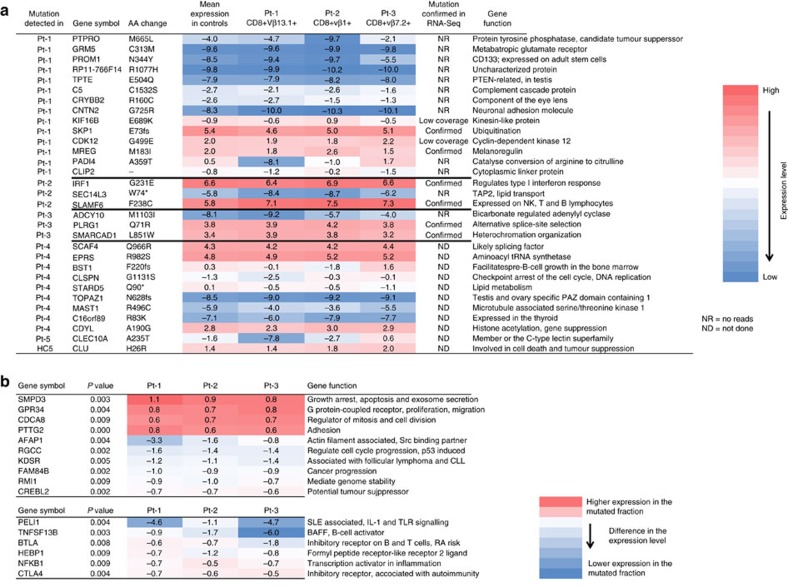
Expression levels of mutated genes and a survival signature in mutation-harbouring cells.CD8+ cells from 3 healthy controls as well as mutation-harbouring CD8+Vβ+ and polyclonal CD8+ T cells from patients 1, 2, and 3 were sorted with flow cytometry. (a) RNA sequencing was performed on the sorted fractions. The normalized mean expression levels calculated from the healthy CD8+ T cells and from the patients’ polyclonal CD8+ fractions are presented in the control expression column. In the following columns, each sorted population containing the mutated clone is presented individually. (b) The upper panel presents proliferation/survival -associated genes identified by paired analysis of the mutation-harbouring cell populations and their polyclonal background populations. Immunologically important transcripts are presented in the lower panel. The transcripts were filtered with threshold expression level 0, FC>1,5 or <−1,5 and P<0.01. Abbreviations: Aa, amino acid; fs, frameshift; *, stop-codon gained; -, splice-site acceptor mutation. The function of the gene was retrieved from the RefSeq database and noll-hypothesis was tested using ANOVA in the Qlucore software package.